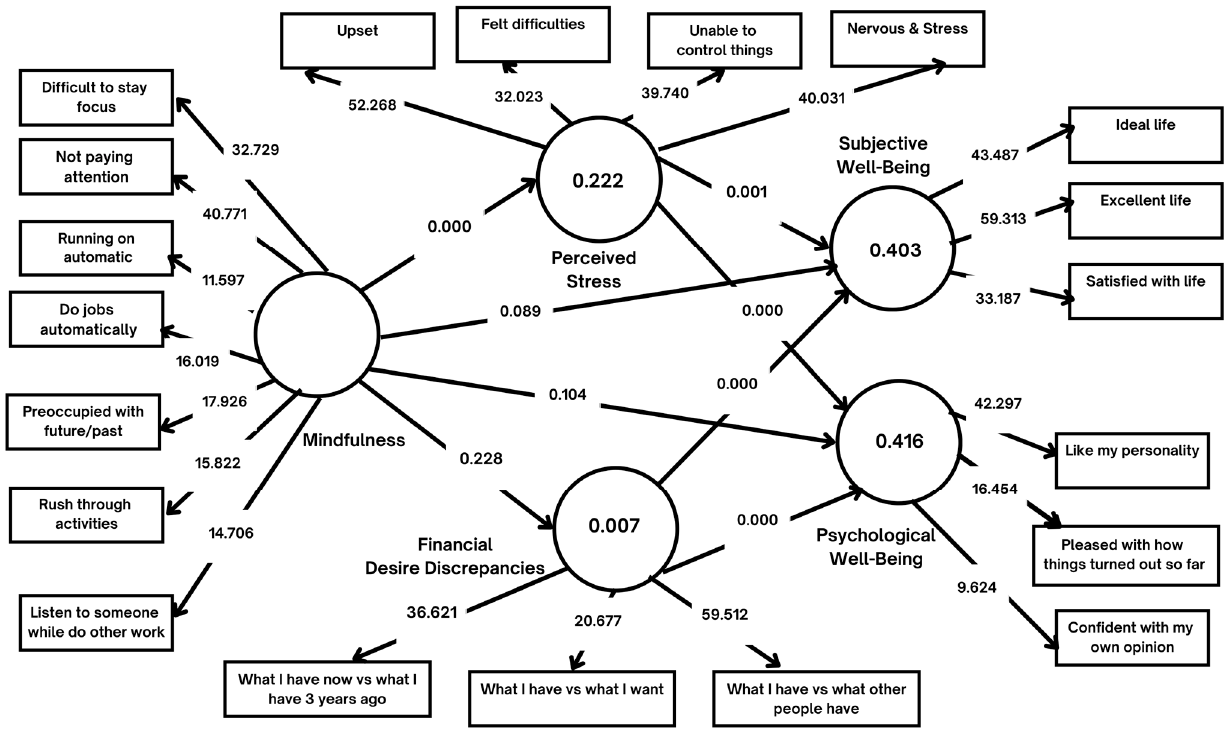
Figure 3. Structural Model.